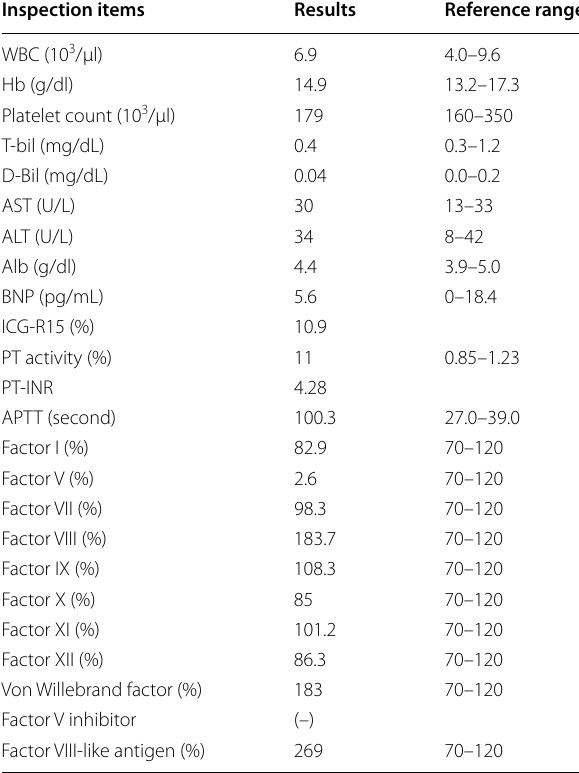
Table1 Preoperative blood test